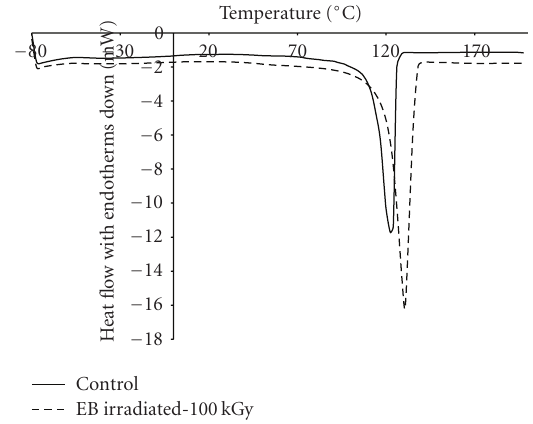
Figure 1: Melting endotherms of unfilled polymer matrix for control and EB-irradiated systems.